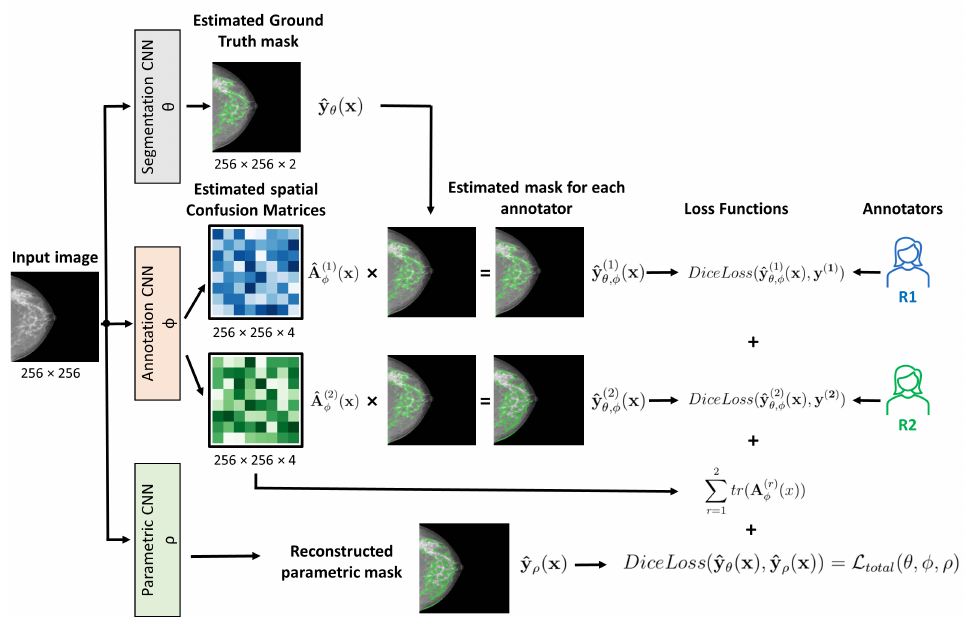
Figure 3. Schematic representation of the proposed (CM-YNet) architecture showing how the total loss function is computed. The segmentation and parametric convolutional neural networks (CNNs) are integrated in the Y-Net model described above. At inference, the output of the segmentation network ˆy θ ( x ) is used to obtain a new